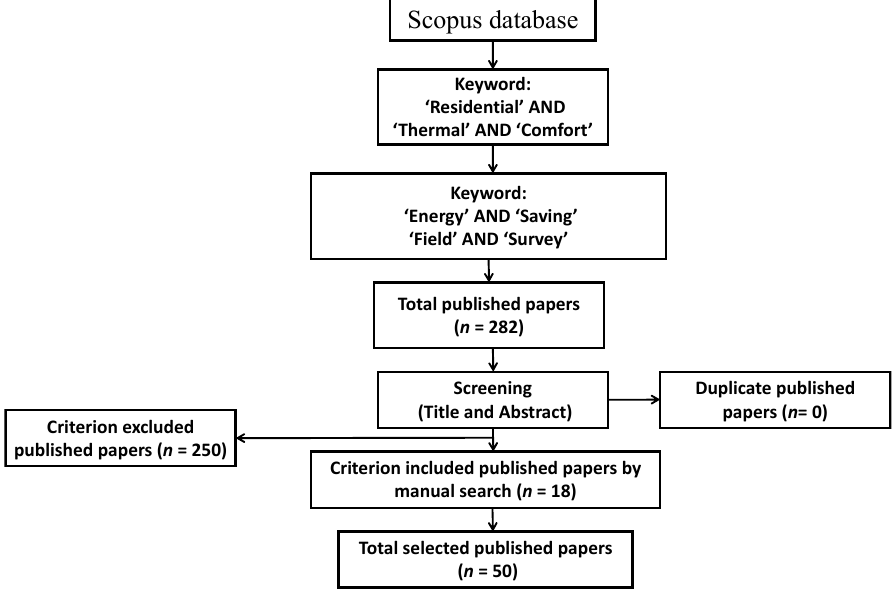
Figure 1. Systematic review process ( n is the number of published papers).